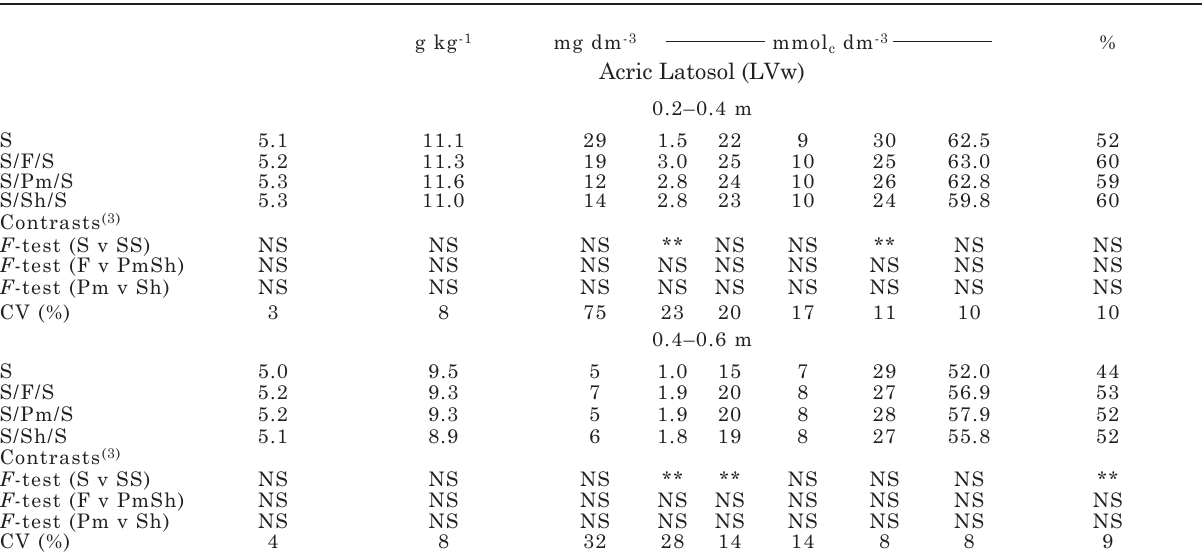
table 7. continue Soil use (2)